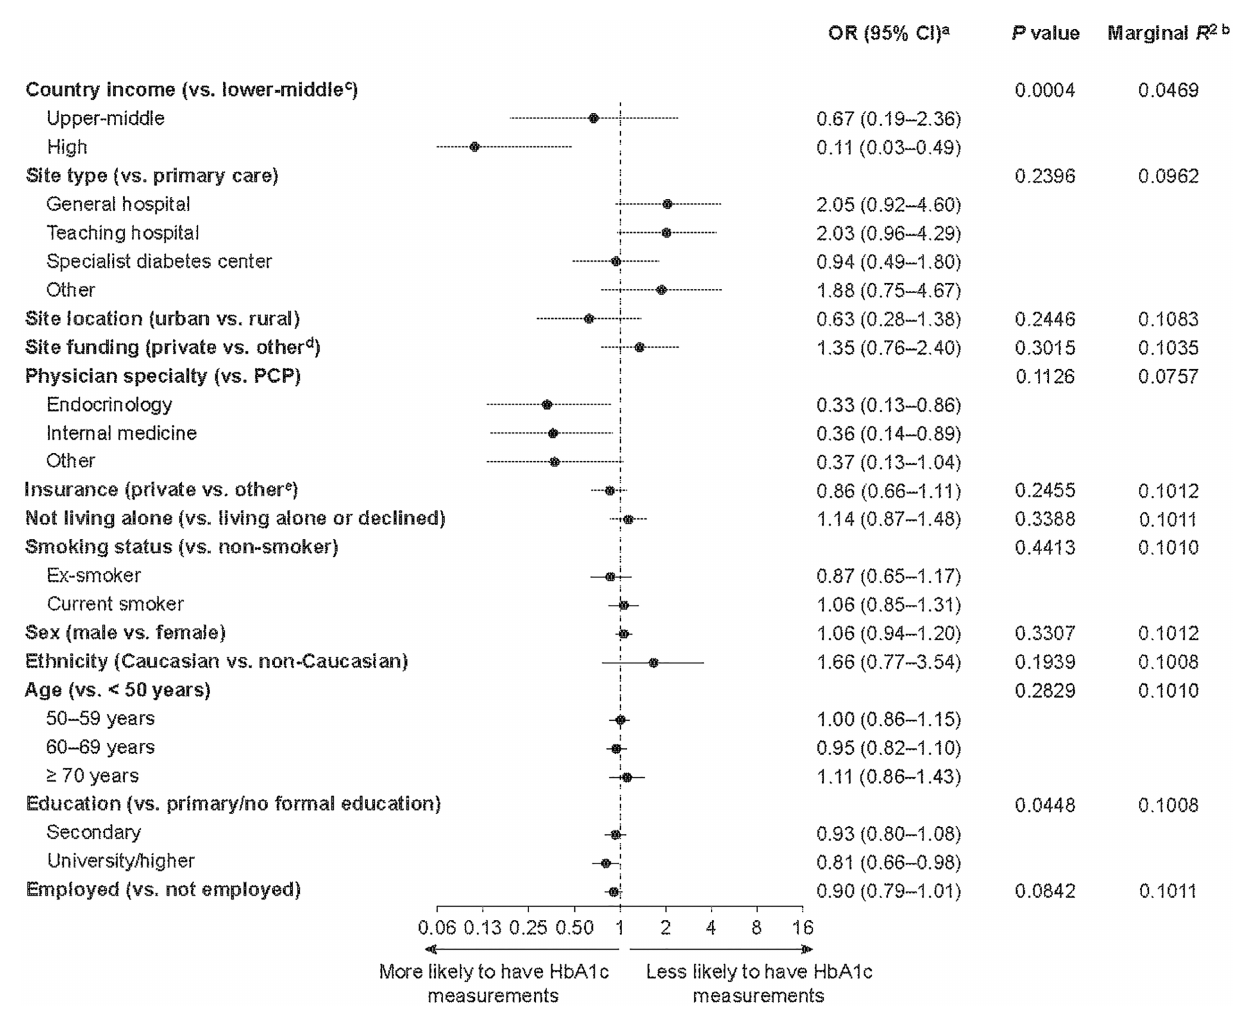
FIGURE 1 | Factors associated with a lack of HbA1c measurements in patients enrolled in the DISCOVER study at baseline. a ORs were calculated using three-level hierarchical models, with patients nested in sites and sites nested in countries and were adjusted for all variables in the fi gure. b Each R 2 was calculated when the corresponding variable was removed from the model. The lower the resulting R 2 value, the more important the removed variable was to the fi t of the model. c Countries were categorized by 2015 gross national income per capita into lower-middle-income (US$1,005 – 3,955), upper-middle-income (US$3,956 – 12,235) and high-income ( ≥ US$12,236) countries. d Public or governmental, or mixed, funding. e Public, mixed or none. CI, con fi dence interval; HbA1c, glycated hemoglobin; OR, odds ratio; PCP, primary care